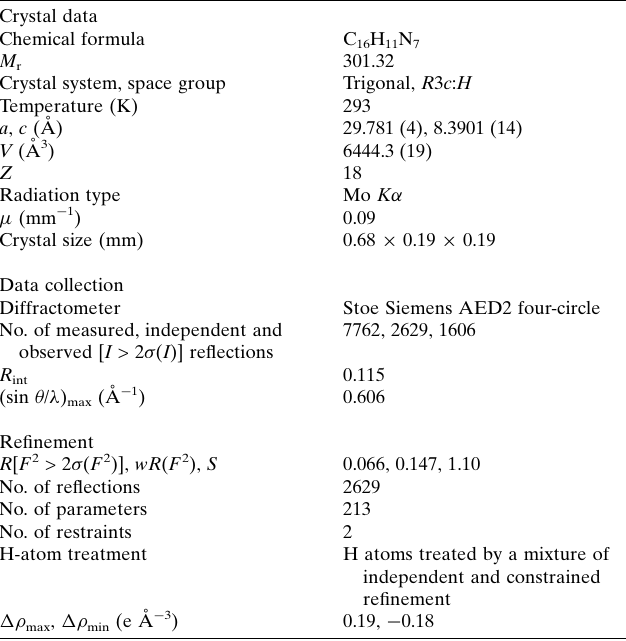
Crystal data Chemical